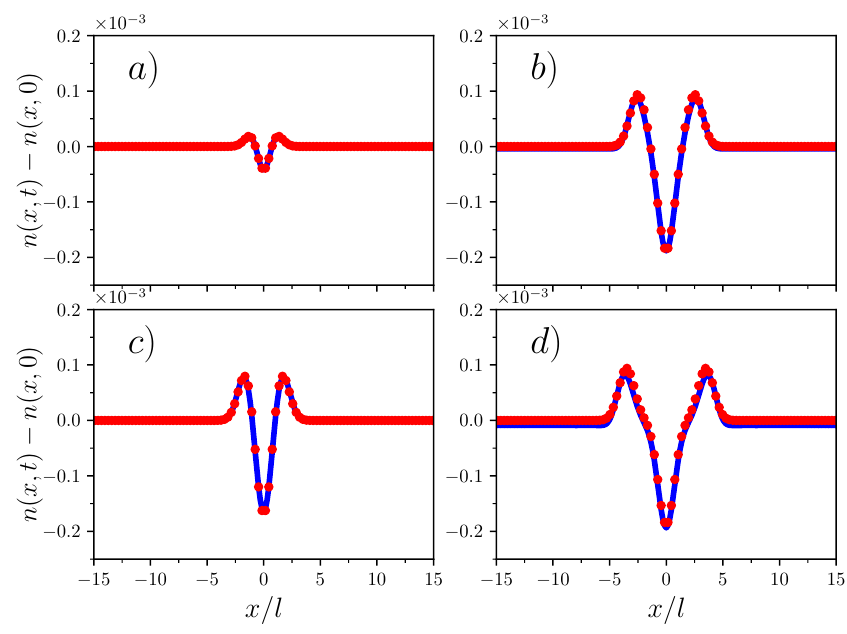
Figure 3: Time evolution of the density of the Bose gas, n ( x , t ) − n ( x ,0 ) in a shallow harmonic trap. The quantity is shown in the units 25 / l , as in the homogeneous case. The GPE results are shown by the solid blue curves; the linearized solution of Eq. (25) is presented using red dots. The perturbation potential is given by the ( x ) = ħ h 2 (cid:112) e − x 2 / l 2 . Numerical calculations are implemented Gaussian potential, V tr π ml 2 (cid:0) ħ h (cid:1) for N = 1500, g = 1.0 , and different values of η . The frequency of the harmonic ml (cid:1) ≈ 100 l that = 0.05 (cid:0) ħ h which gives the Thomas-Fermi radius, R potential is ω TF tr ml 2 ensures the almost flat density in the bulk of the gas. Panels (a), (b), (c) and (d) (cid:128) (cid:138) (cid:128) (cid:138) (cid:128) (cid:138) (cid:128) (cid:138) ml 2 ml 2 ml 2 ml 2 } for η = show the snapshots at t ≈ { 0.5 ,1.5 ,2.5 ,3.5 ħ h ħ h ħ h ħ h